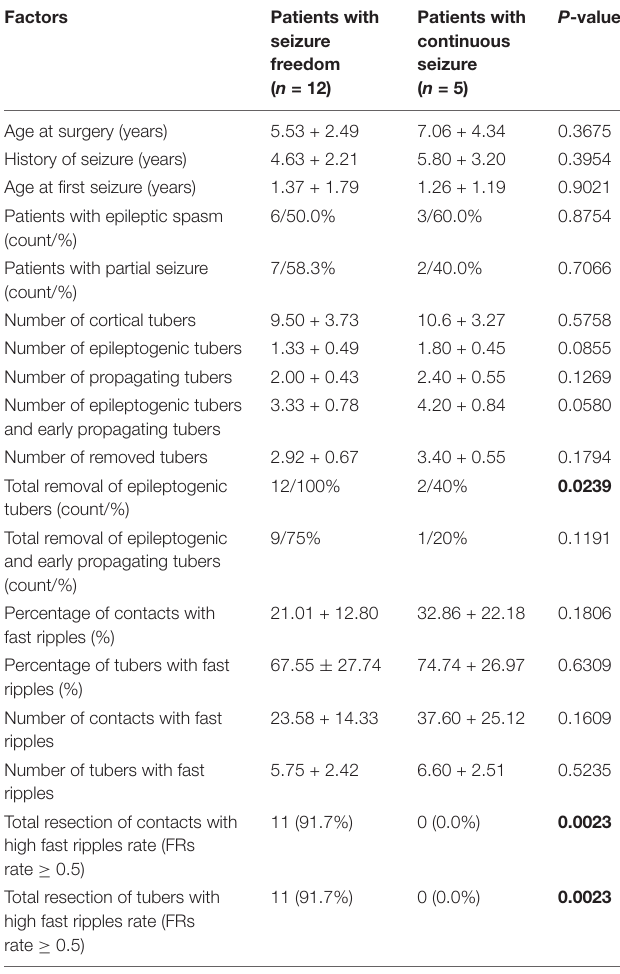
TABLE 2 | Influence factors of postoperative seizure